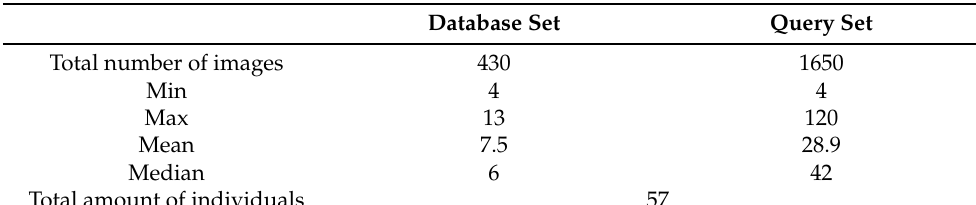
Table 1. Image distributions for the database and the query sets.